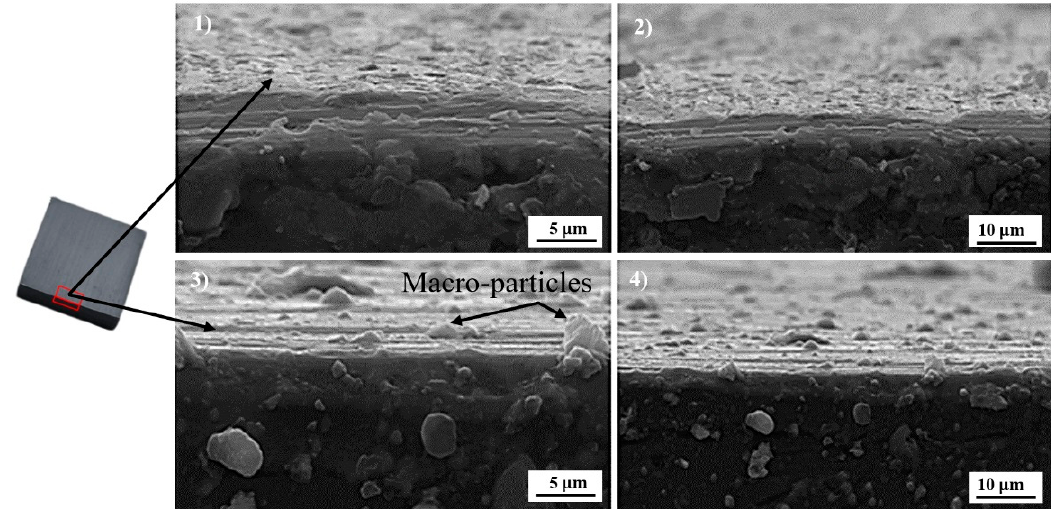
Figure 6. The surface morphology of CrN (No. 1 and 2) and TiN (No. 3 and 4) on steel substrates as determined by CAE at magnifications of 2500 × ( right ) and 5000 × ( left ).